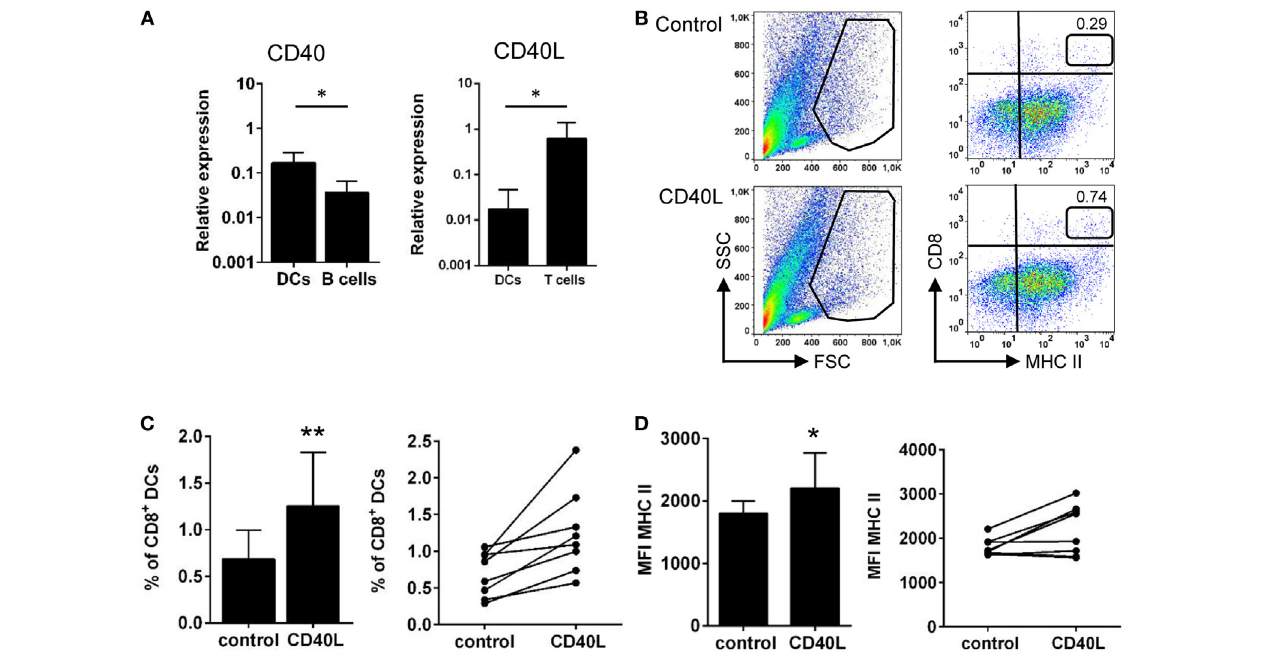
FigUre 7 | CD40 ligand (CD40L) stimulates gill CD8 + dendritic cells (DCs). (a) CD8 + DCs from gills, together with T cells and IgM + B cells from spleen, were isolated by FACS sorting, and total RNA was obtained. The relative expression of CD40 and CD40L to the endogenous control elongation factor 1 α was calculated for each sample, and mean ( + SD) values from two experiments, involving three animals per experiment, were calculated. Asterisks denote statistically significant differences between indicated groups. (B) Gill leukocytes were incubated with CD40L during 48 h and then stained with anti-CD8 α and anti-major histocompatibility complex (MHC) II mAbs. FSC/SSC profiles are shown (left), and a gate for myeloid cells was defined. Two-color CD8/MHC class II dot plots of myeloid gated cells are also shown (right panels). Percentage of myeloid CD8 + MHC II + cells among the total number of cells in each gate is shown in the upper right corner. Average percentage of CD8 + DCs in control medium or treated with CD40L was calculated (c) , as well as the MFI of MHC II on these populations (D) . The percentage of CD8 + DCs and the MFI of MHC II are also shown for each individual fish. Data are represented as mean + SD ( n = 6). Asterisks denote statistically significant differences between the values obtained in the CD40L-treated group and the corresponding untreated group (* p ≤ 0.05 and ** p ≤